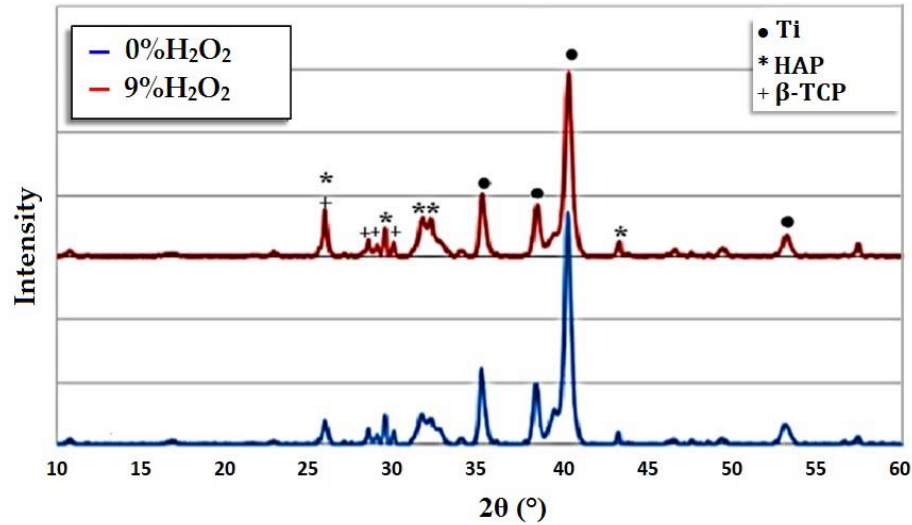
Figure 3. X-ray diffraction (XRD) pattern of HAP coating deposited with 0% and 9% of H 2 O 2